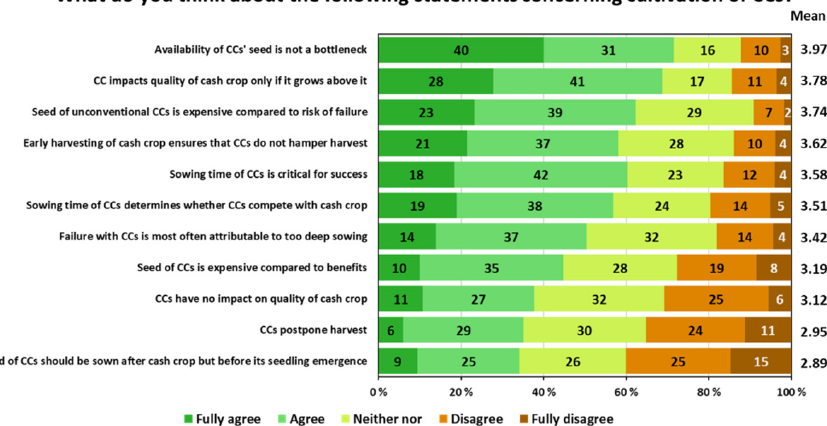
Figure 1. The distribution and mean (in order of decreasing value) of the farmers’ answers (N = 1130)